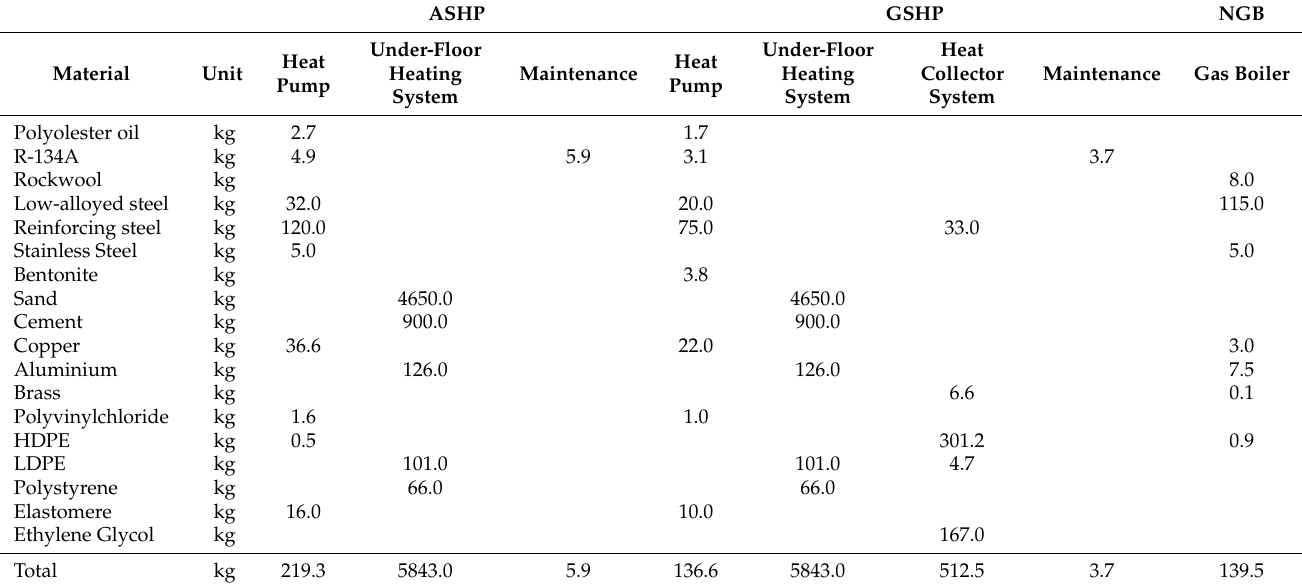
Table 1. Material requirements for heating technologies. Data source: [35]. ASHP GSHP NGB